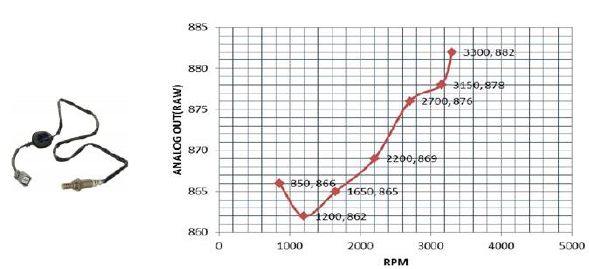
Fig. 10. Oxygen / Lambda Sensors with analog output vs. rpm